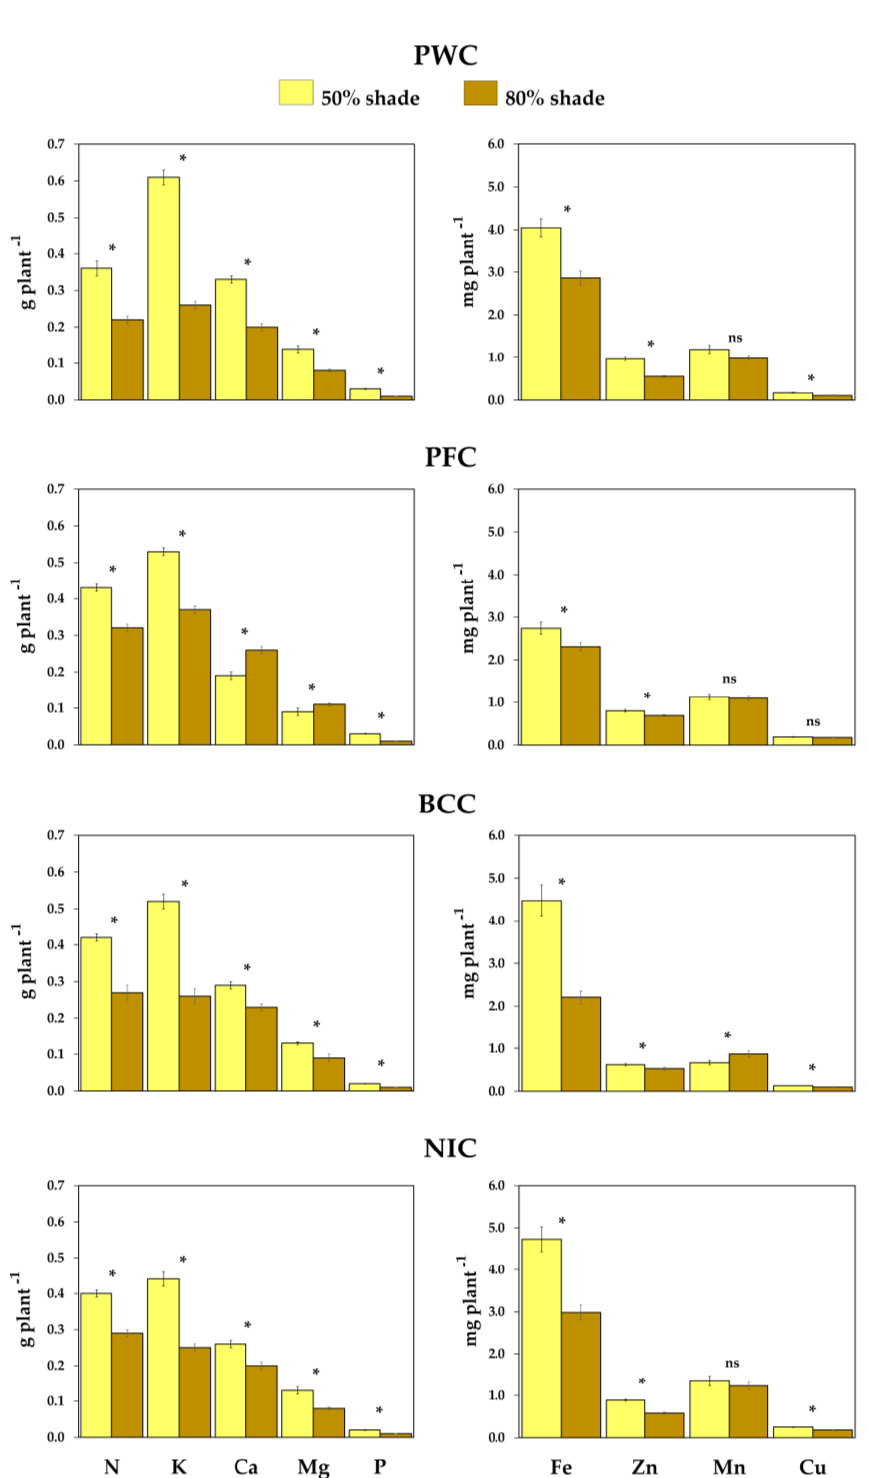
Figure 2. Nutrient uptake (U, macronutrients in g plant − 1 or micronutrients in mg plant − 1 , ± SE) of cacao genotypes subjected to two levels of shade (50%, 80%). PWC: wild cacao (from river basins of Peruvian Amazon) [ n = 14]; PFC: Peruvian farmers’ cacao [ n = 15]; BCC: Brazilian cacao [ n = 14]; NIC: national and international cacao collections [ n = 15]. All paired bar graphs that have an * above have significant differences and those with “ns” above do not have significant differences between shade levels (Scott and Knott test, p ≤